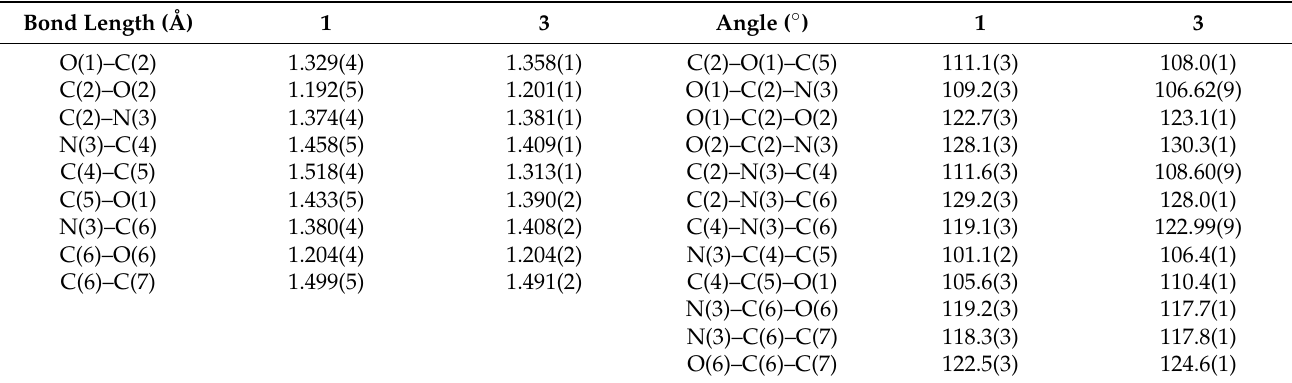
Figure 1. Structures of compounds 1 and 3 (thermal ellipsoids at 50% probability). Table 1. Bond lengths and angles for 1 and 3.